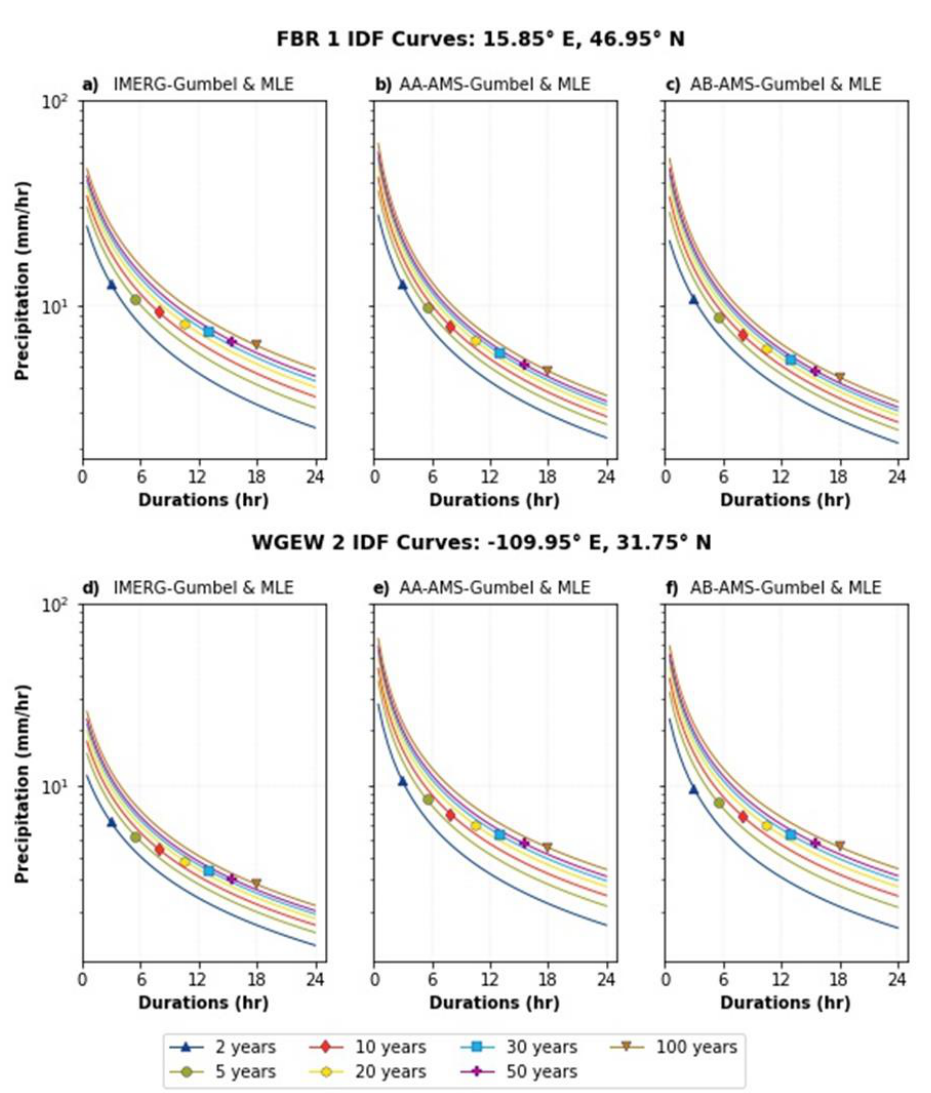
Figure A5. IDF curves fitted with Gumbel and MLE over FBR 1 ( top ) and WGEW 2 ( bottom ) for the 2, 5, 10, 20, 30, 50, and 100 year return periods and durations from half-hour to 24 h. From left to right: IMERG, AA-AMS, and AB-AMS. The marker’s purpose is only to distinguish the IDF curves.